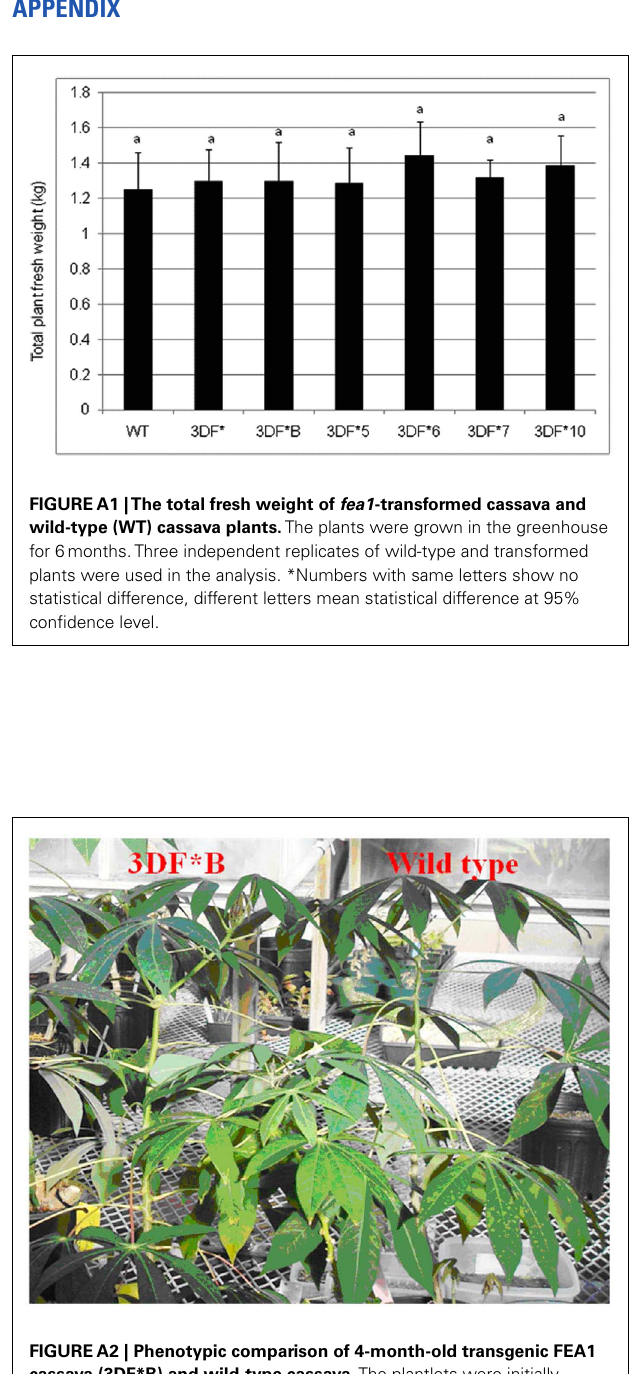
FIGUREA2 | Phenotypic comparison of 4-month-old transgenic FEA1 cassava (3DF*B) and wild-type cassava. The plantlets were initially maintained in a greenhouse growth chamber at 28˚C at a light intensity of 50 µ mol photons/m 2 /s. Plantlets were transferred to 11 (cid:48)(cid:48) × 12 (cid:48)(cid:48) plastic pots filled with Scott’s MetroMix soil (The Scott’s Company, Marysville, OH, USA) after 30days growth in the greenhouse growth chamber.